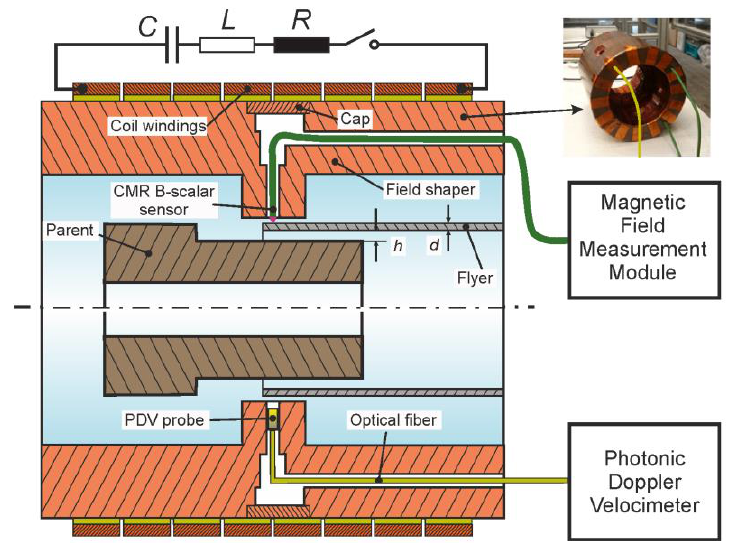
Figure 1. Setup for magnetic pulse welding of tubes to cylinders with a CMR-B-scalar probe for the measurement of the magnetic field and a PVD sensor. In the upper right corner, a picture of the field shaper with the integrated two CMRs and one PDV sensor.